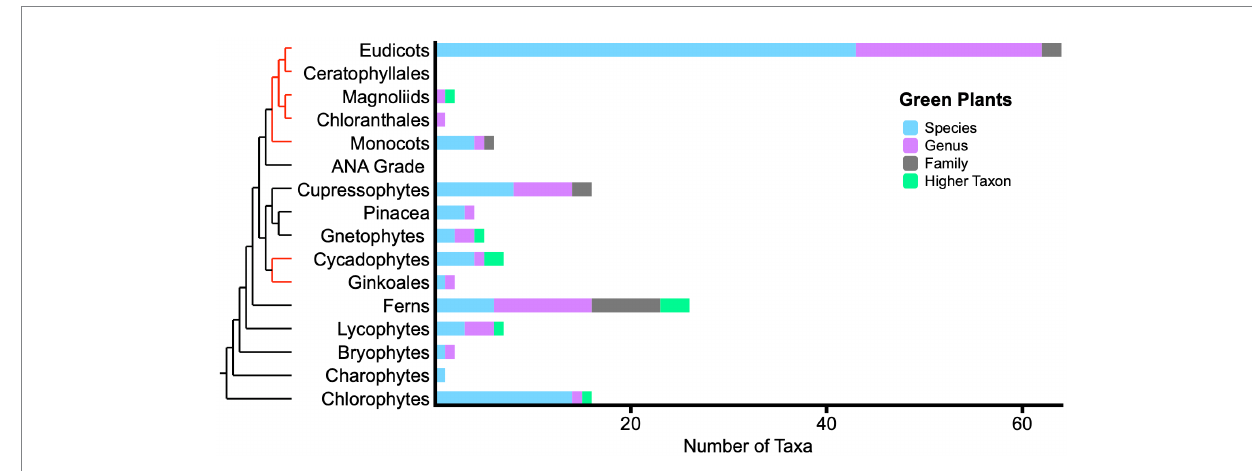
FIGURE 3 Phylogram with bar graph showing the distribution of living fossil taxa across green plants. Bar colors indicate taxonomic ranks of 159 unique taxon names. Red sections of phylogram indicate substantial uncertainty of relationship. Acronym: ANA grade (Amborellales, Nymphaeales, and